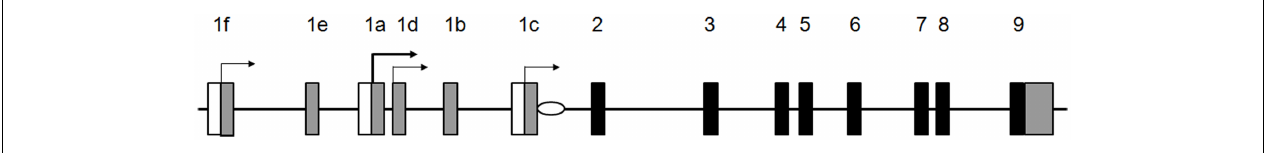
FIGURE 1 | Organization of humanVDR locus . Black boxes represent protein coding exons, gray – non-coding exons localized in the regulatory region of the gene. Horizontal arrows indicate transcriptional start sites.White boxes represent promoter regions, white oval – the RA-responsive cis -regulatory element.